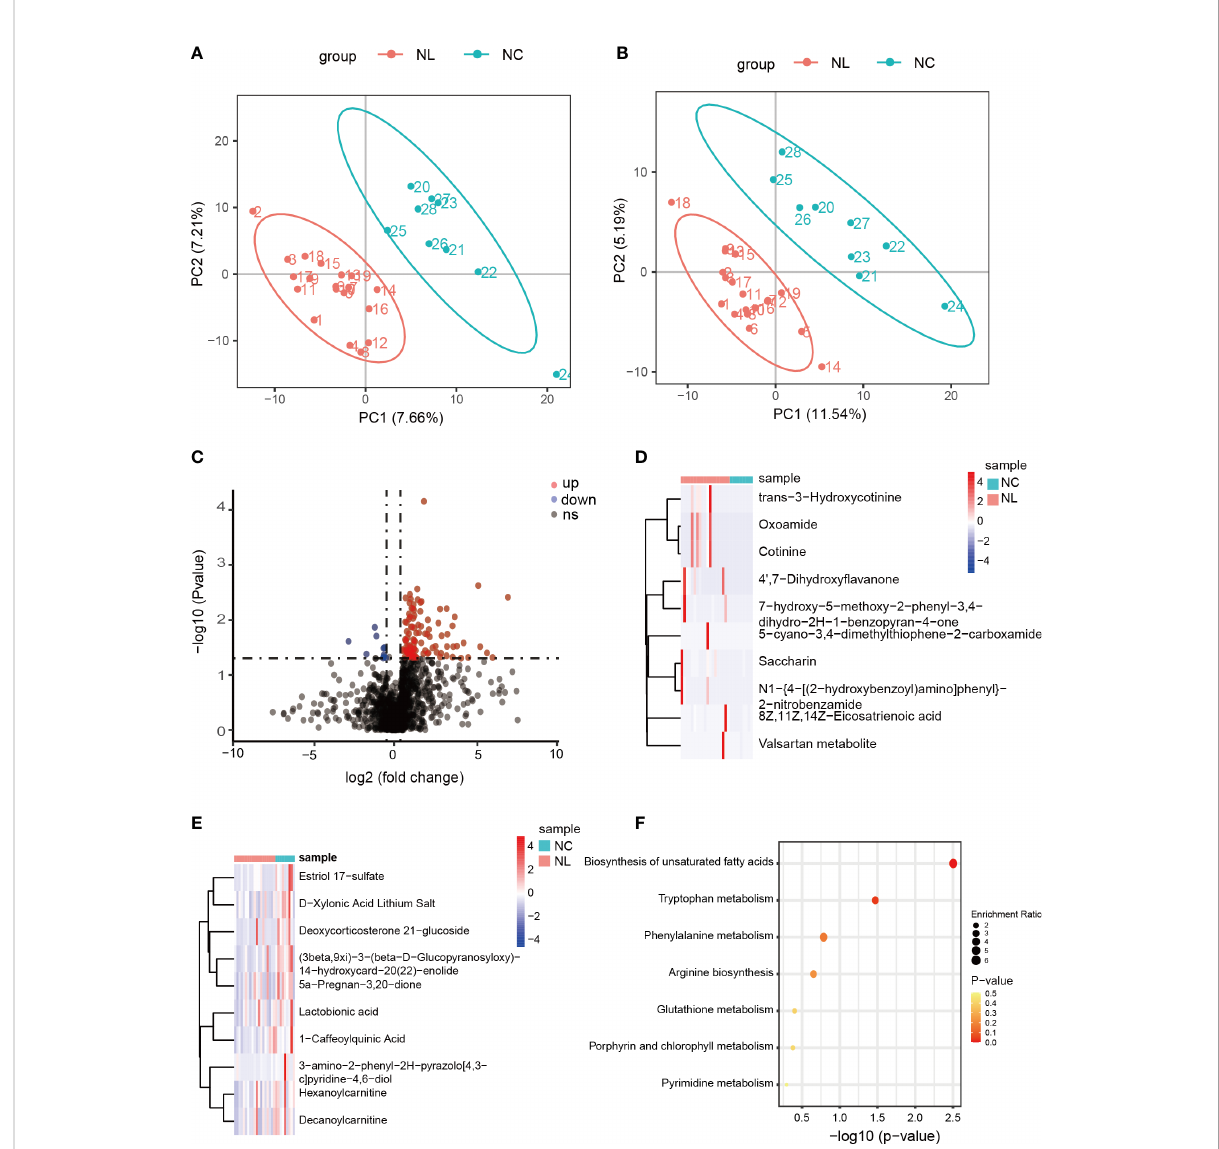
FIGURE 3 Differentially expressed metabolites between control individuals and nephrolithiasis patients. (A) Partial least squares discriminant analysis (PLS- DA) of positively charged metabolites. (B) PLS-DA of negatively charged metabolites. (C) Volcano plot of differentially expressed metabolites (DEMs), characterized by fold change ≥ 1.2 or ≤ 0.667 (P < 0.05) with a threshold of VIP ≥ 1. Red dots represent up-regulated metabolites, blue dots represent down-regulated metabolites. (D) Heatmap of top 10 up-regulated metabolites in nephrolith patients. (E) Heatmap of top ten down-regulated metabolites in nephrolith patients. (F) KEGG enrichment analysis of the